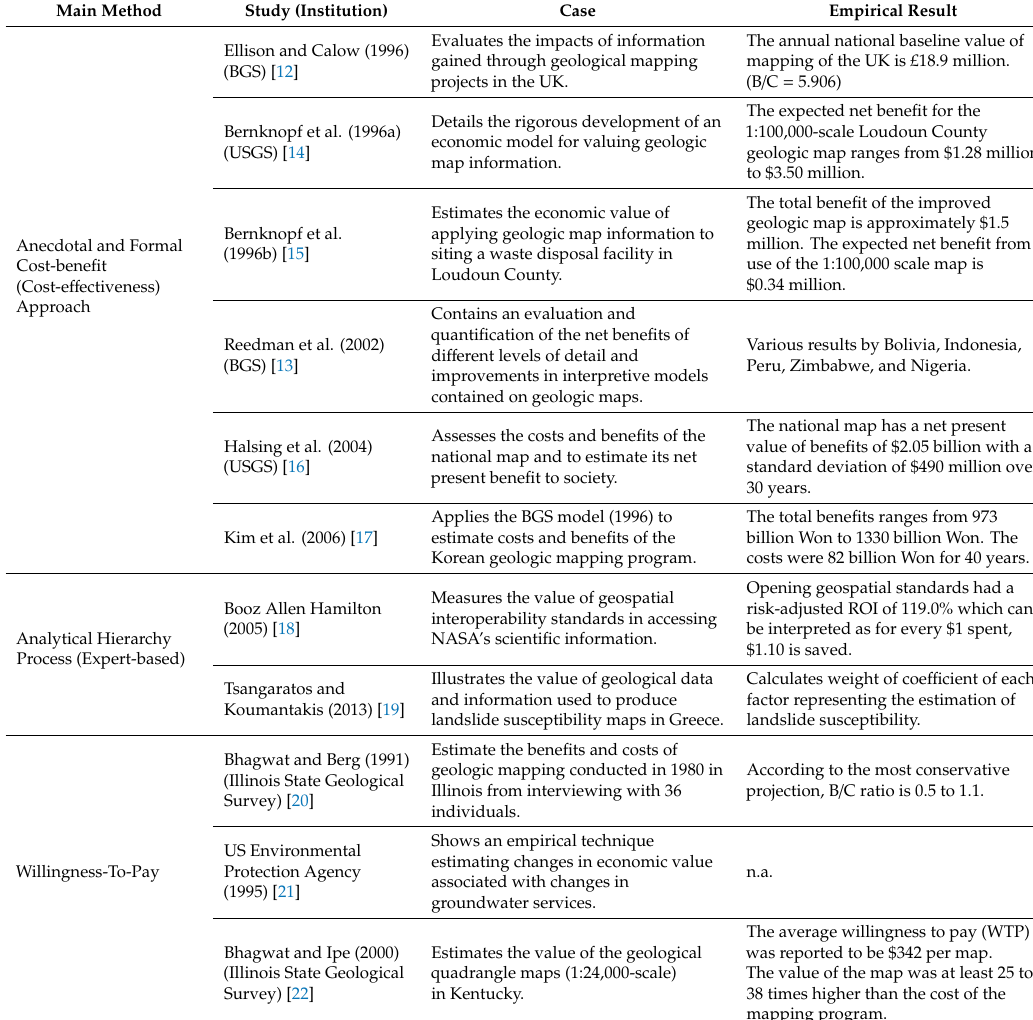
Table 1. Previous studies measuring the value of geological information